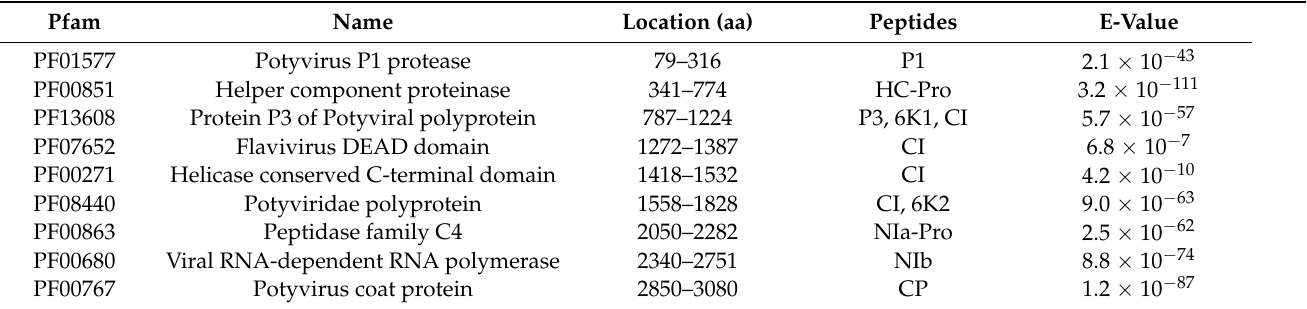
Table 1. Results of an InterProScan search for conserved Pfam domains present in the polyprotein of